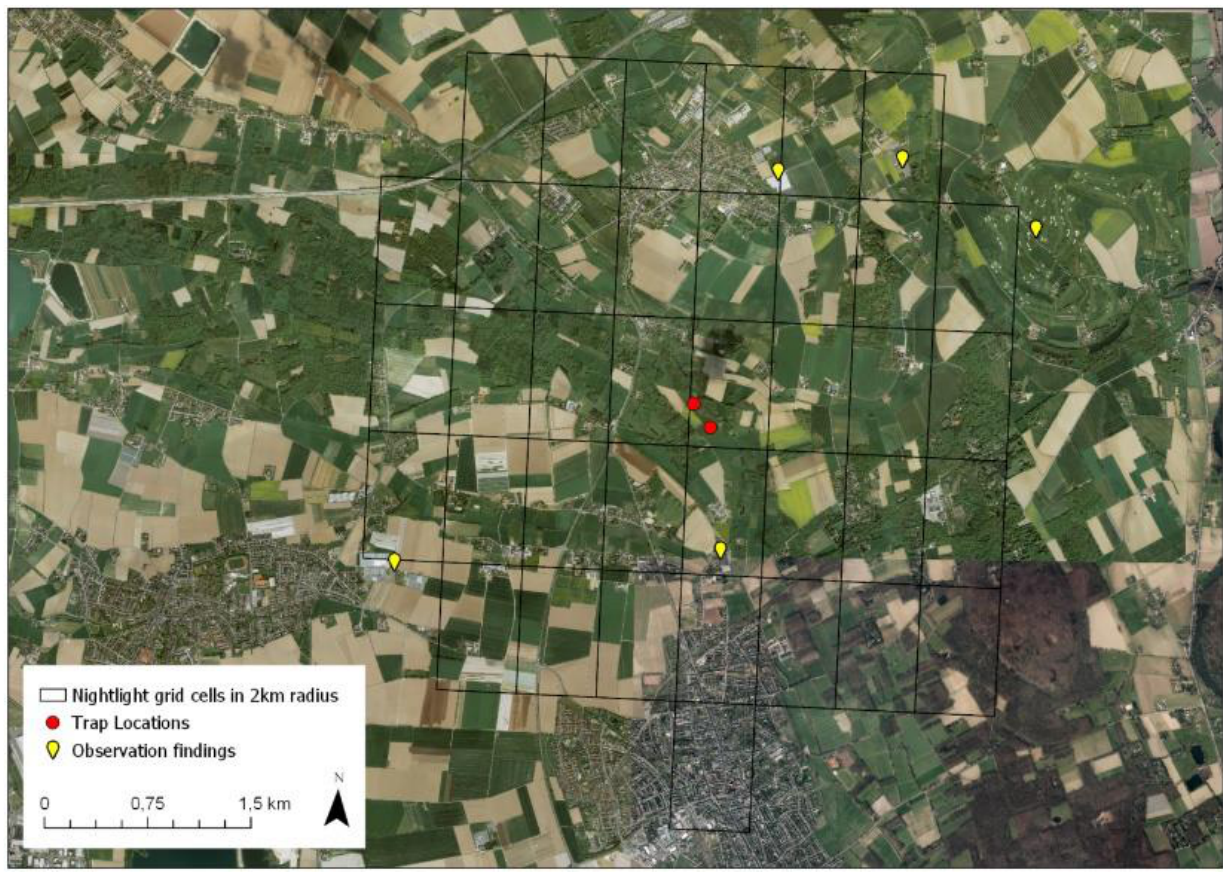
Figure A4. Grid cells (black lines) represent the pixels that overlapped the 2 km radius around the insect trap locations (red points). Within the 2 km radius, we identified five potential landscape features (yellow points) potentially contributing to increasing nightlight intensity within the pixels they are centered in/adjacent to. These features were not present in the 1989 aerial imagery and were identified as changes in the 2013 imagery (with 2013 imagery shown). These features include a greenhouse complex, three new greenhouse extensions, and a golf course.